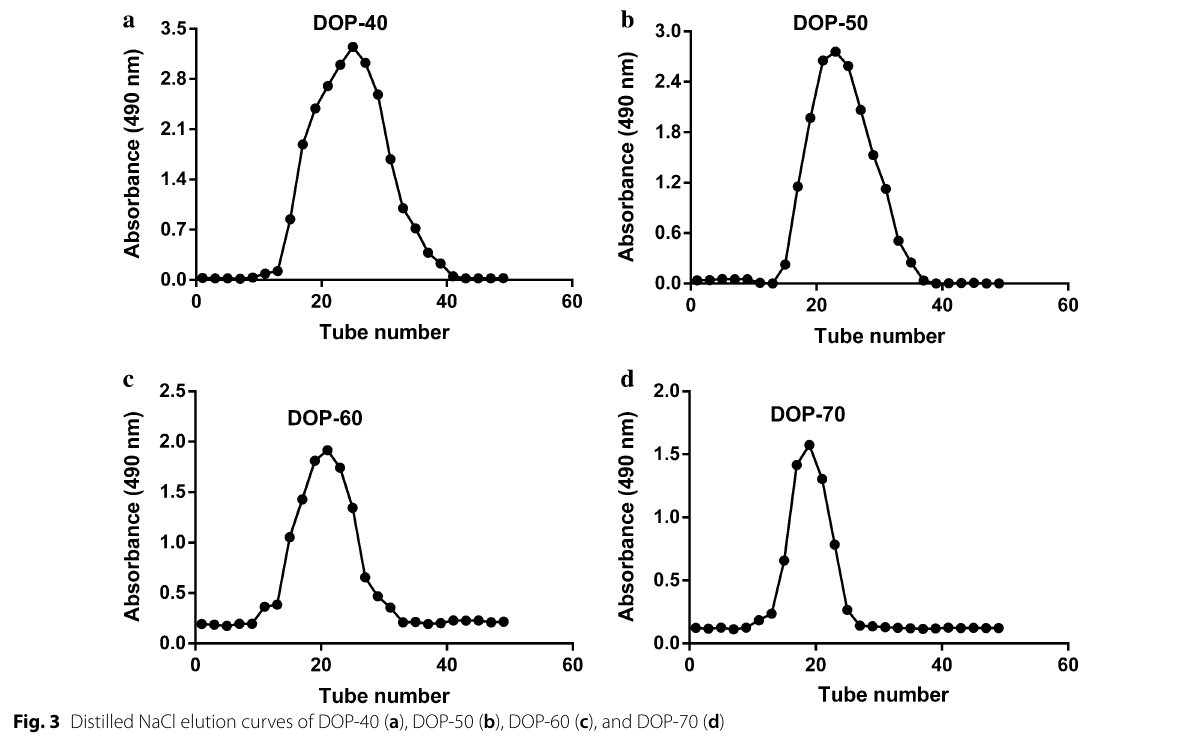
Fig. 3 Distilled NaCl elution curves of DOP-40 ( a ), DOP-50 ( b ), DOP-60 ( c ), and DOP-70 ( d )